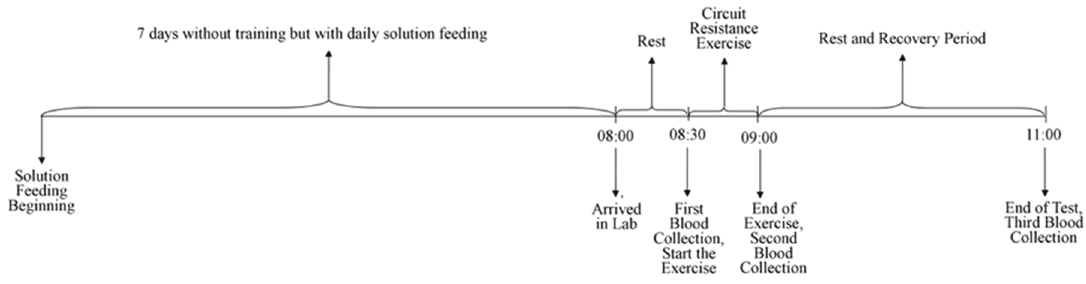
Figure 2. Research Design and Blood